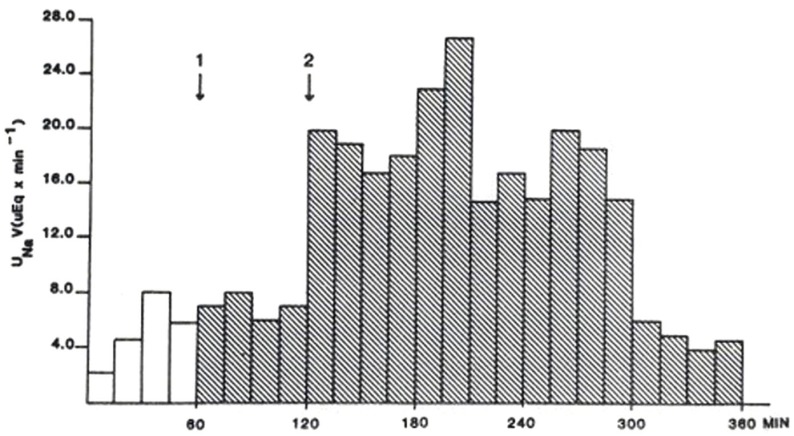
Rat natriuretic bioassay of semi-purified 12 kDa protein representing 2.5 mL of original plasma. First arrow designates time of injection of control solution. The second arrow designates the time of injection of the 12 kDa protein. From Ref. (10) with permission from the editors.